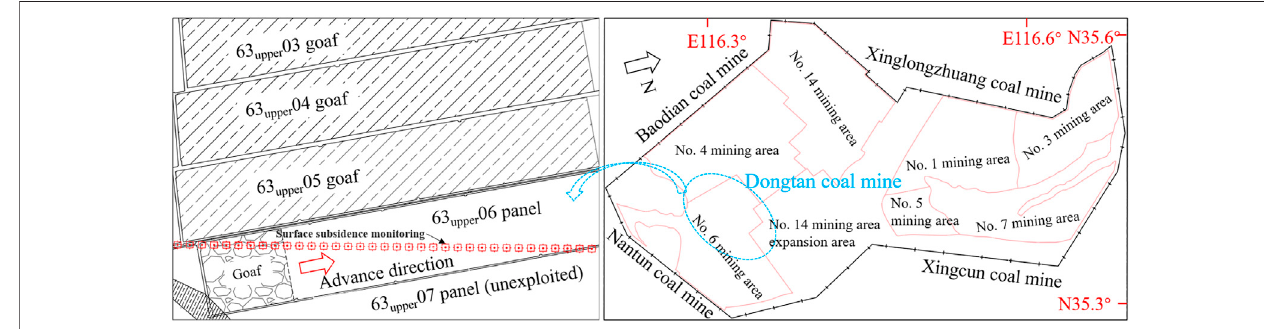
FIGURE 1 | Distribution of mining areas in Dongtan coal mine and panels in No. 6 mining area.